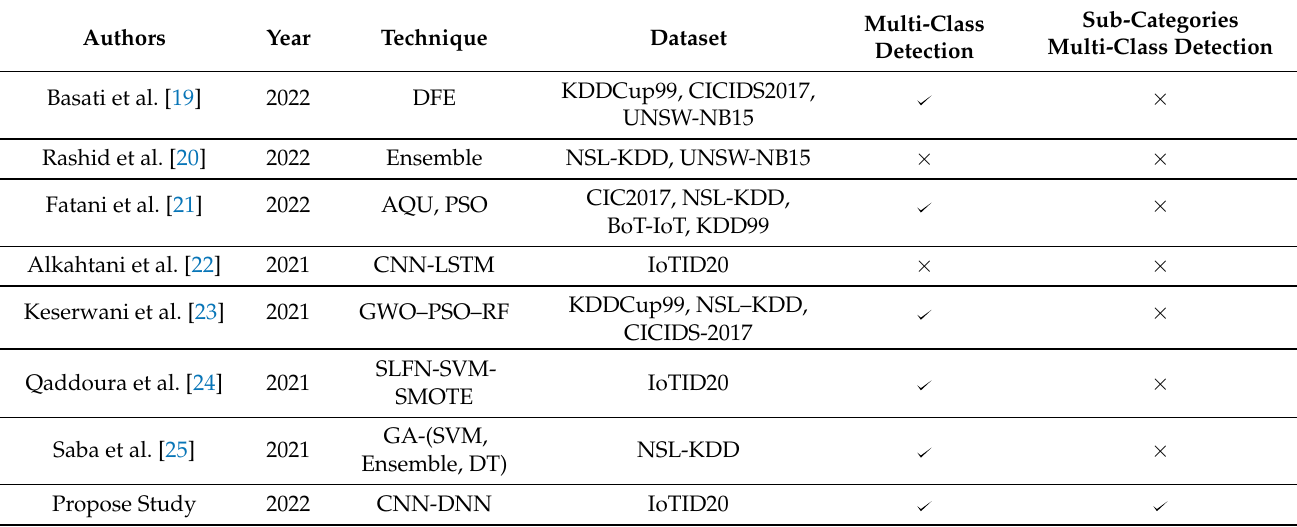
Table 1. A comparison of existing work related to intrusion detection in